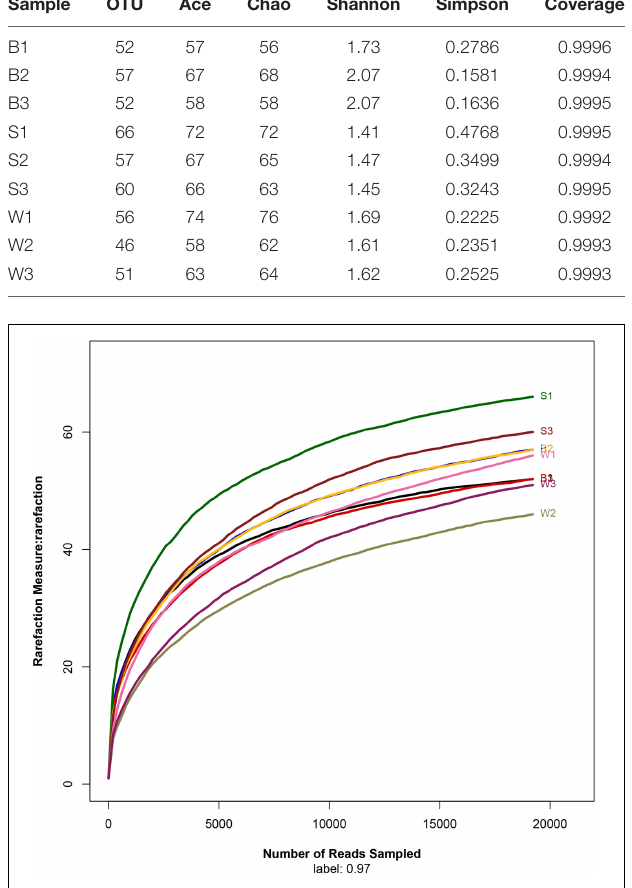
FIGURE 2 | Rarefaction analysis of the different samples. Rarefaction curves of OTUs clustered at 97% sequence identity for different samples.